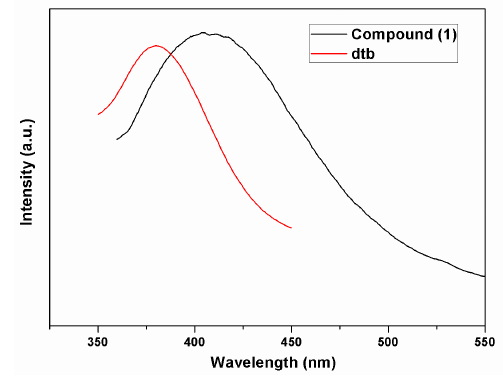
Figure 4. Solid-state luminescent spectra of compound 1 and dtb at room temperature.